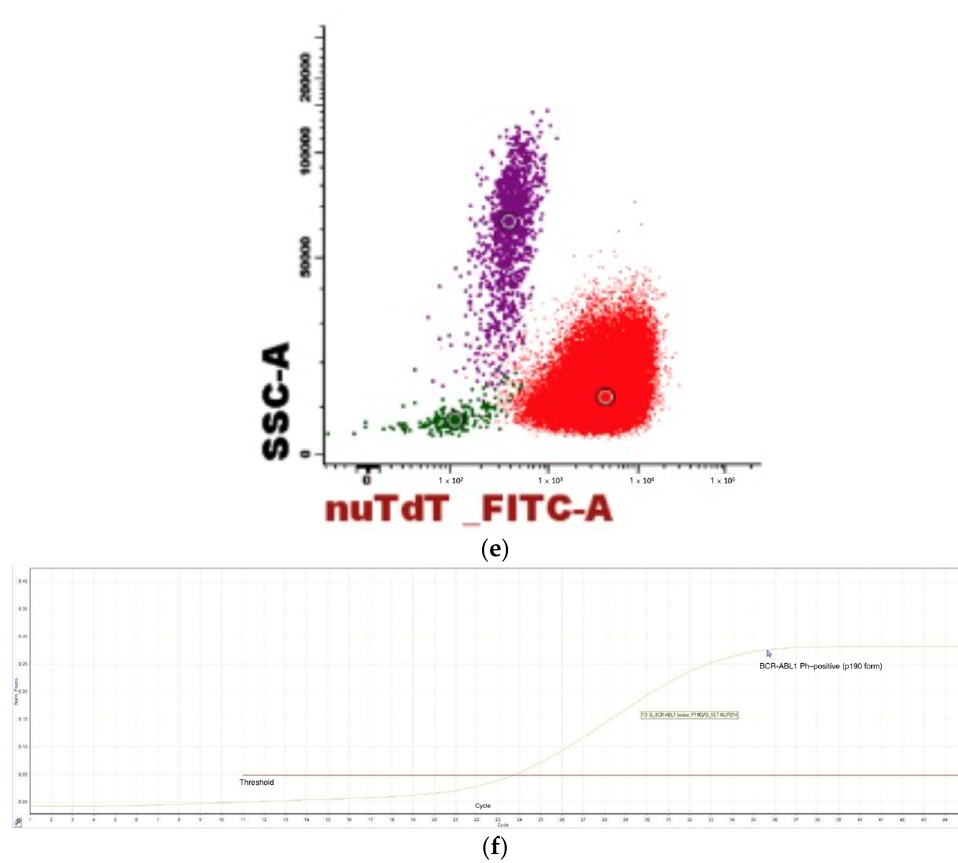
Figure 3. Genetic subtype study of the patient. ( a , b ) the immunophenotype characterization with the use of flow cytometry demonstrated moderate cytoplasmic CD79a, CD19, and CD34 expression. ( c – e ) in B-cell precursor acute lymphoblastic leukemia diagnostic panel, the specimen showed brightness of CD58 and CD10 with moderate expression of TdT. ( f ) reverse transcription polymerase chain reaction revealed signi fi cant expression of the BCR-ABL1 gene (p190 form).